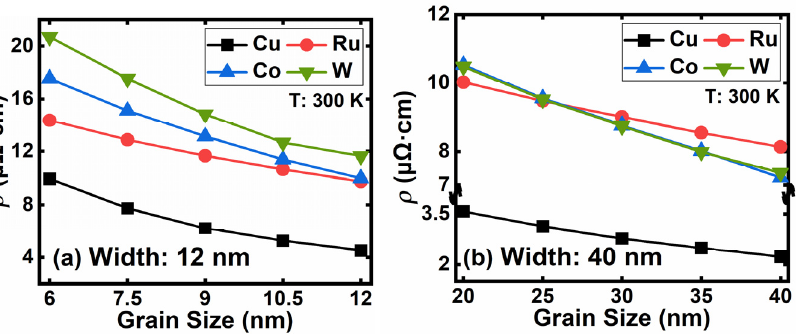
Figure 10. The resistivity of Cu, Ru, Co, and W at different GS with ( a ) 12 nm and ( b ) 40 nm linewidth.